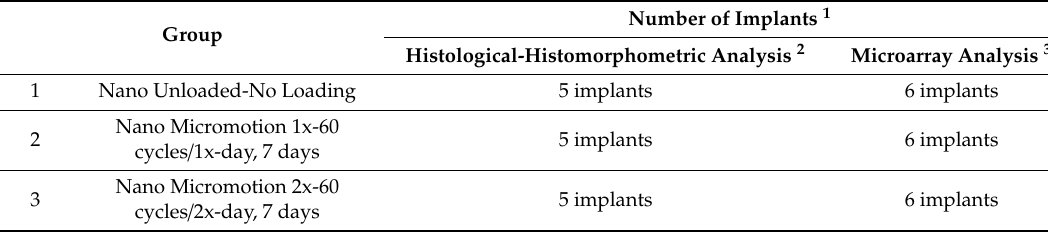
Figure 1. Schematic illustrations of ( A ) each component of the micromotion device and ( B , C ) the bone plate positioned on the proximal tibia metaphysis. ( B ) The bone plate is placed using two Ti-alloy Retopins ® . The implant is guided through the middle of the micromotion device. ( C ) A cap is screwed onto the motion device to hold the implant in place and to secure it against accidental motion due to animal activity. The cap contains a central hole, which allows the loading device to create implant displacement without removing the cap. ( D ) Mark-10 Force Gauge loading component. Table 1. Experimental groups and loading